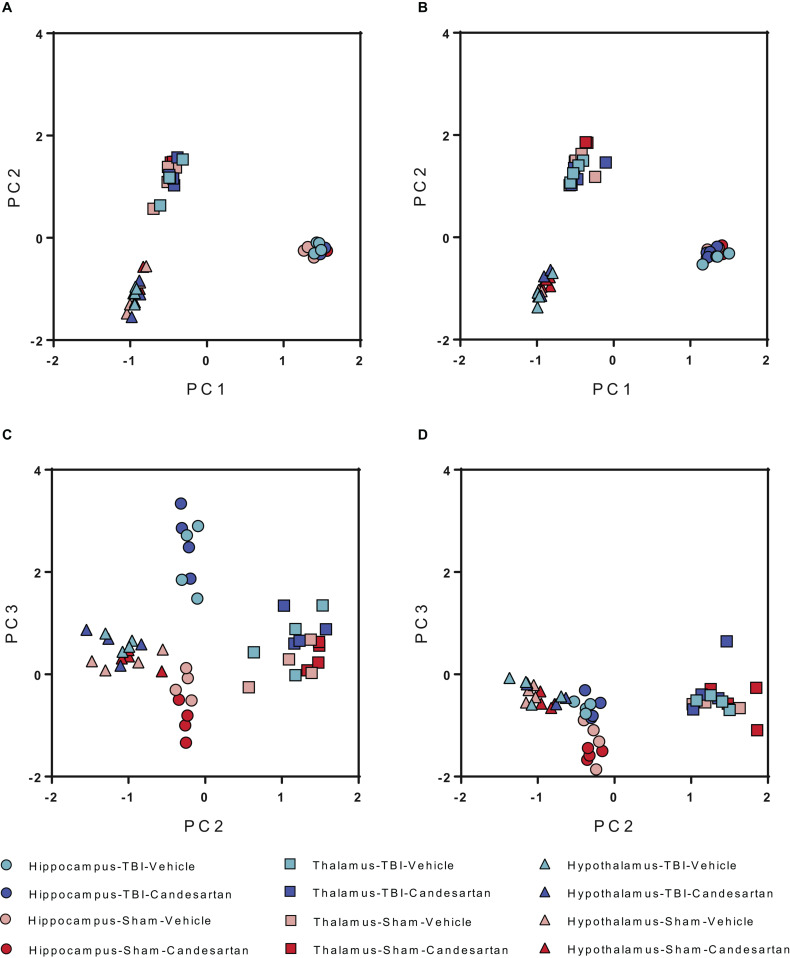
Principal Component Analysis (PCA) of Differentially Expressed Genes at 3 and 29 dpi. PCA analysis shows the largest differences between brain regions at both (A) 3 dpi and (B) 29 dpi for all conditions. Differences are also seen between TBI and sham in the hippocampus at (C) 3 dpi but not at (D) 29 dpi (n = 4/group).